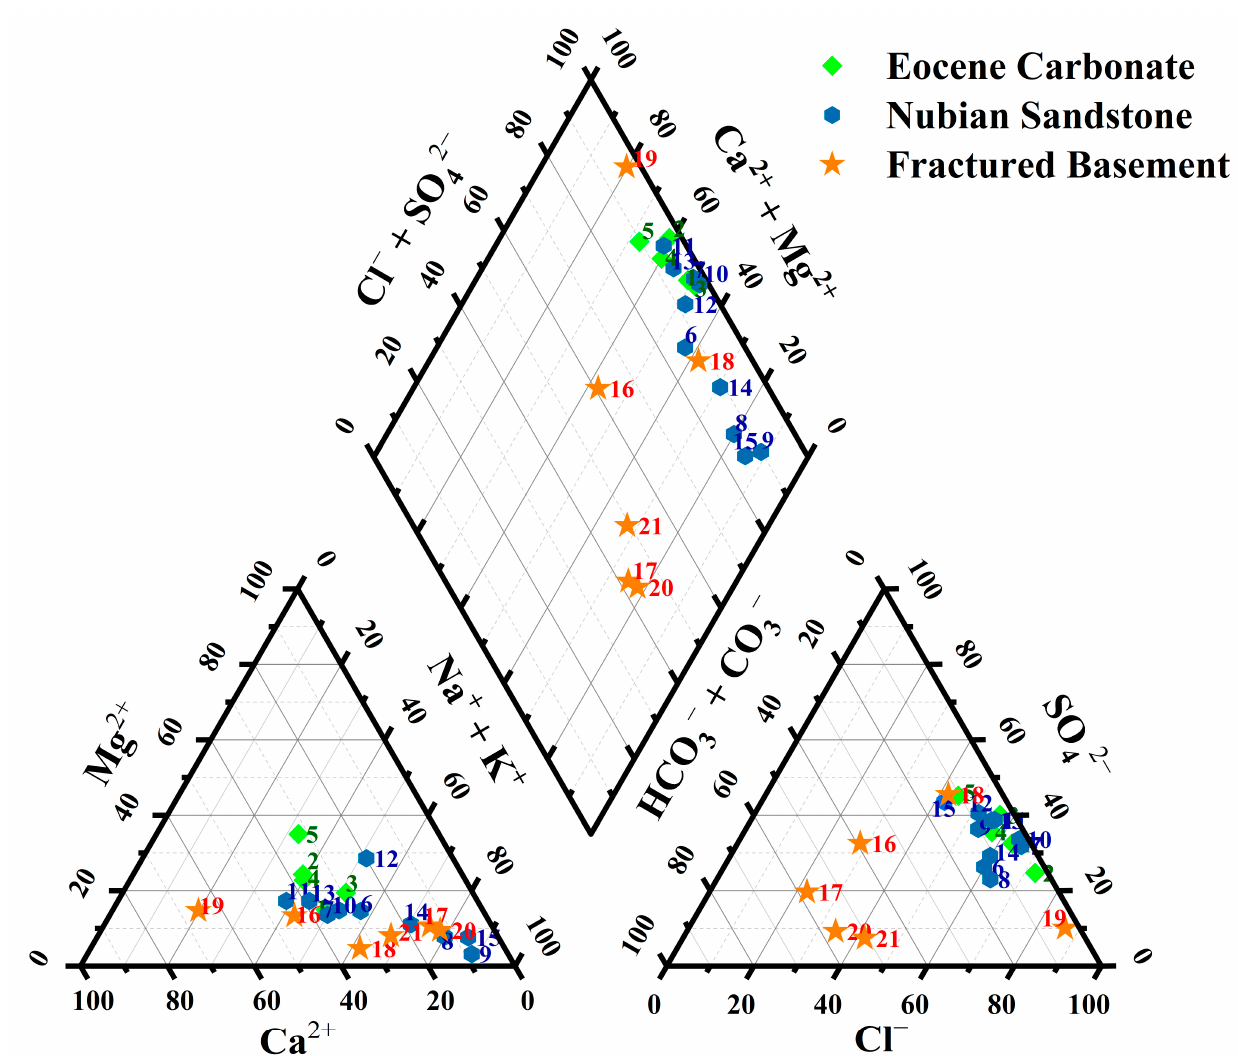
Figure 4. Piper plot of groundwater samples in EOC, NS, and FB aquifers. The dissolution of carbonate minerals like calcite (CaCO 3 ) and dolomite (CaMg(CO 3 ) 2 ) which are responsible for enriching of Ca 2+ and Mg 2+ was explored by (Ca 2+ + Mg 2+ ) vs. (HCO 3 − + SO 42 − ) scatter diagram. Most of the NS and FB sample points lie below the equiline with few along it and above (Figure 6c), which indicates the predominance of silicate weathering. On the other hand, EOC sampling points lie above that line